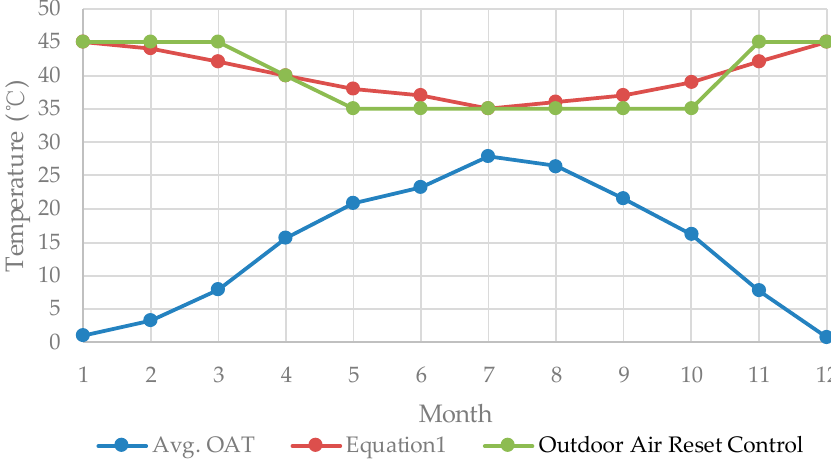
Figure 3. Monthly averaged SHW temperature by Equation (1) and the OARC (Figure 2).